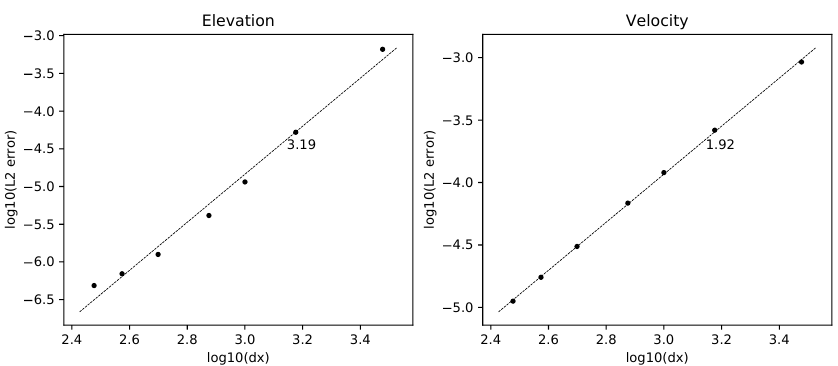
Figure 1. Convergence of the L 2 error in the standing wave test case. Tested element sizes were 3000, 1500, 1000, 750, 500, 375, and 300m. The number indicates the slope of the least-squares best-fit line (dashed